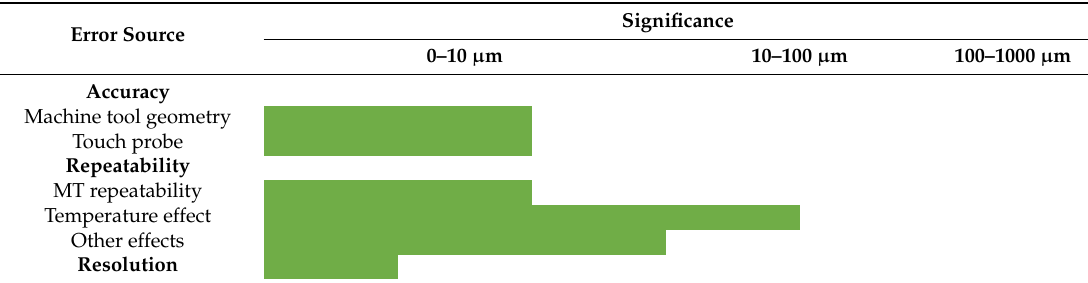
Table 2. Error budget for small and medium size MTs.